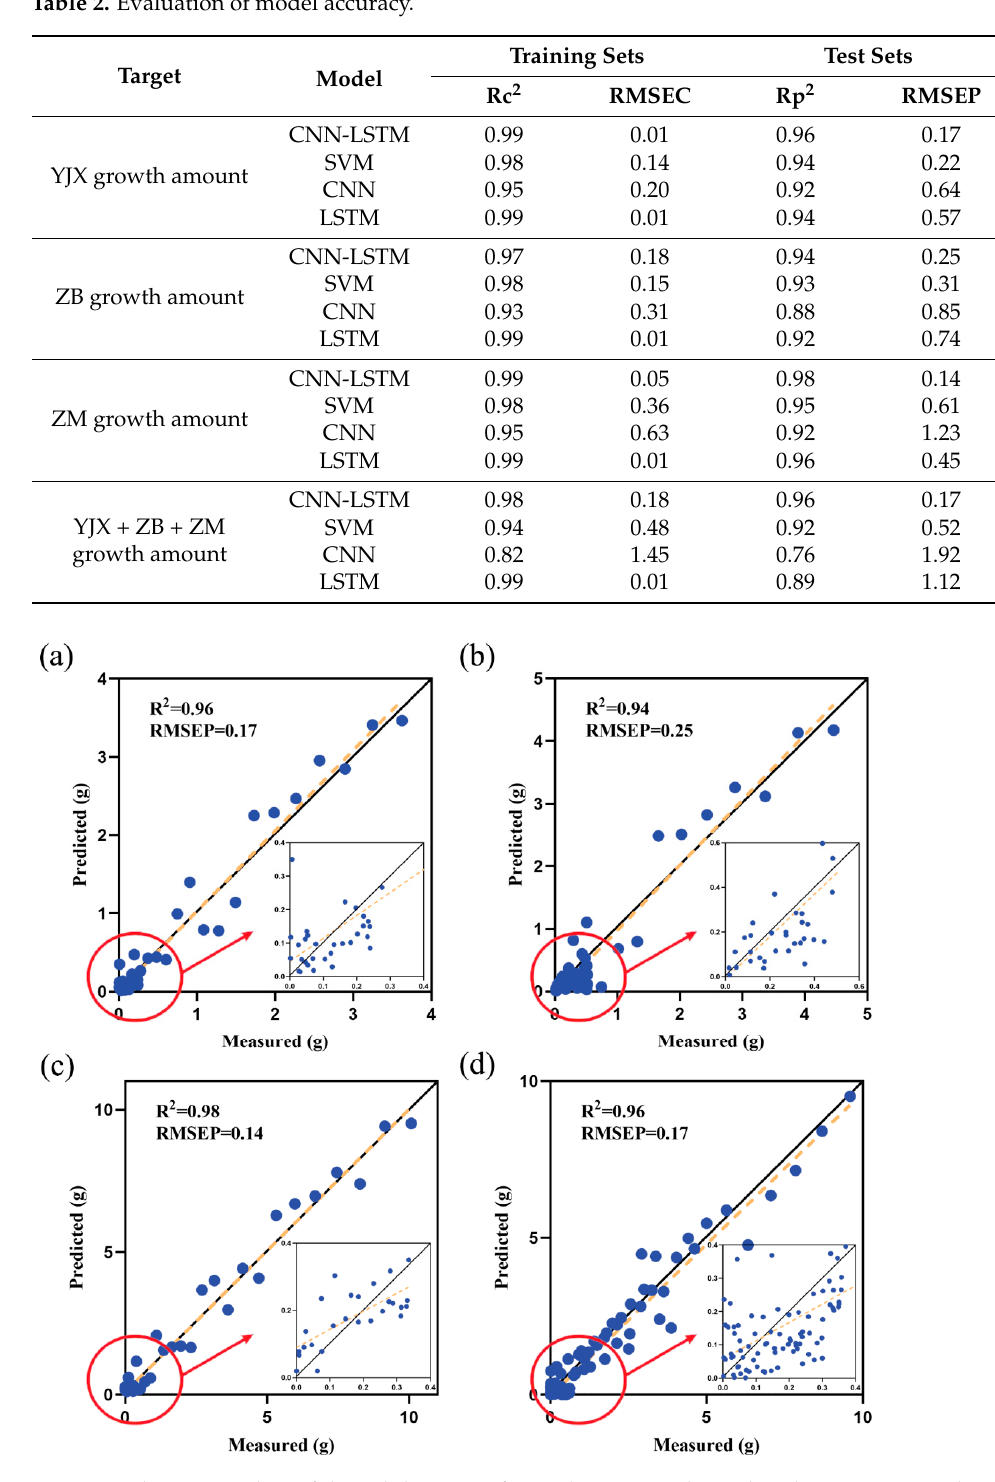
Figure 6. The scatter plots of the validation set for evaluating single- and multi-variety GSTS